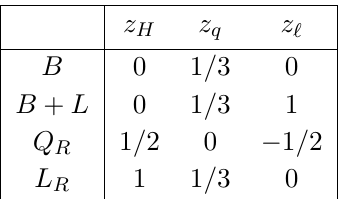
Table 3. The benchmark models considered in this paper; Q R refers to right-handed quarks, and L R to right-handed